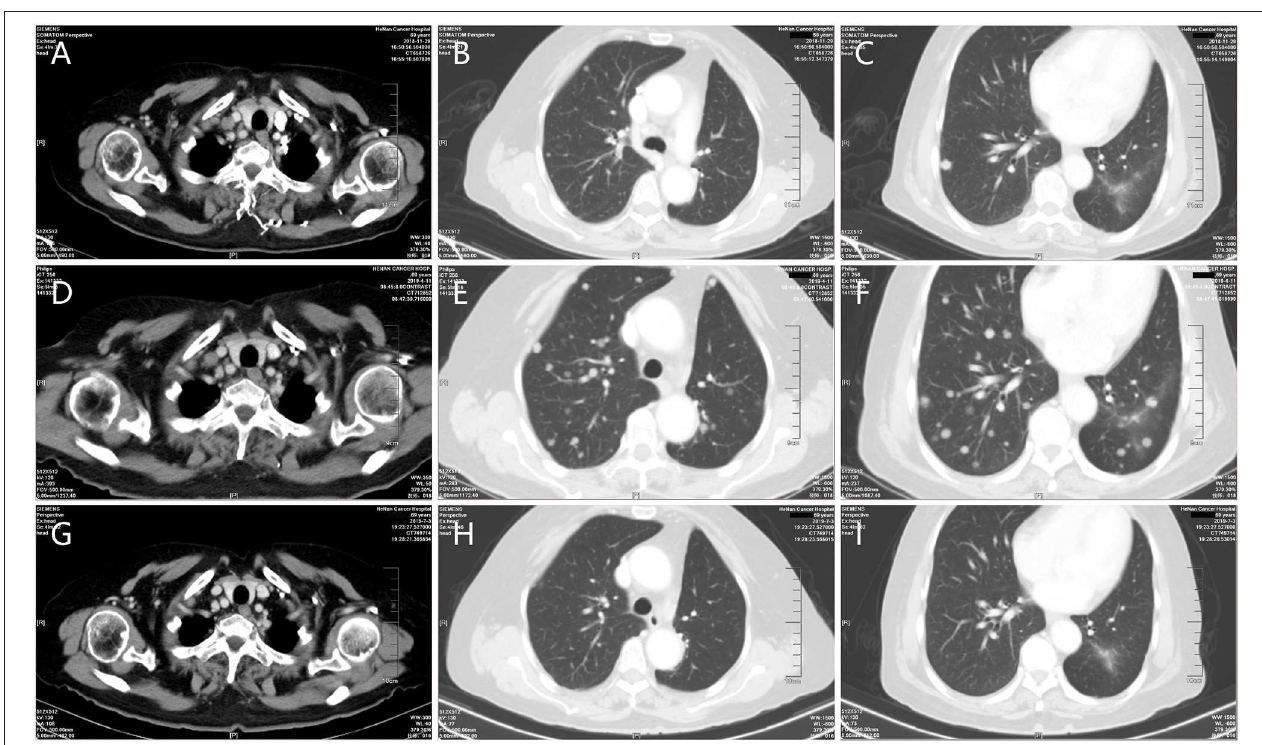
FIGURE 1 | Representative computed tomography (CT) obtained throughout the clinical course. (A–C) CT during initial therapy (prior to the first time of pembrolizumab administration). (D–F) Progressive disease while receiving pembrolizumab therapy. (G–I) Significant reduction in tumor burden following the fourth dose of pembrolizumab after